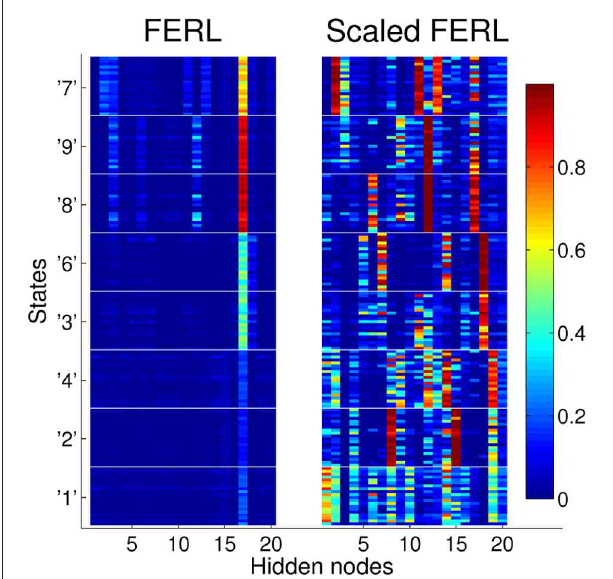
FIGURE 6 | Typical hidden activation patterns after successful learning for FERL (left panel) and scaled FERL (right panel). The figures show the activation of all 20 hidden nodes for all 20 digit images for all states.